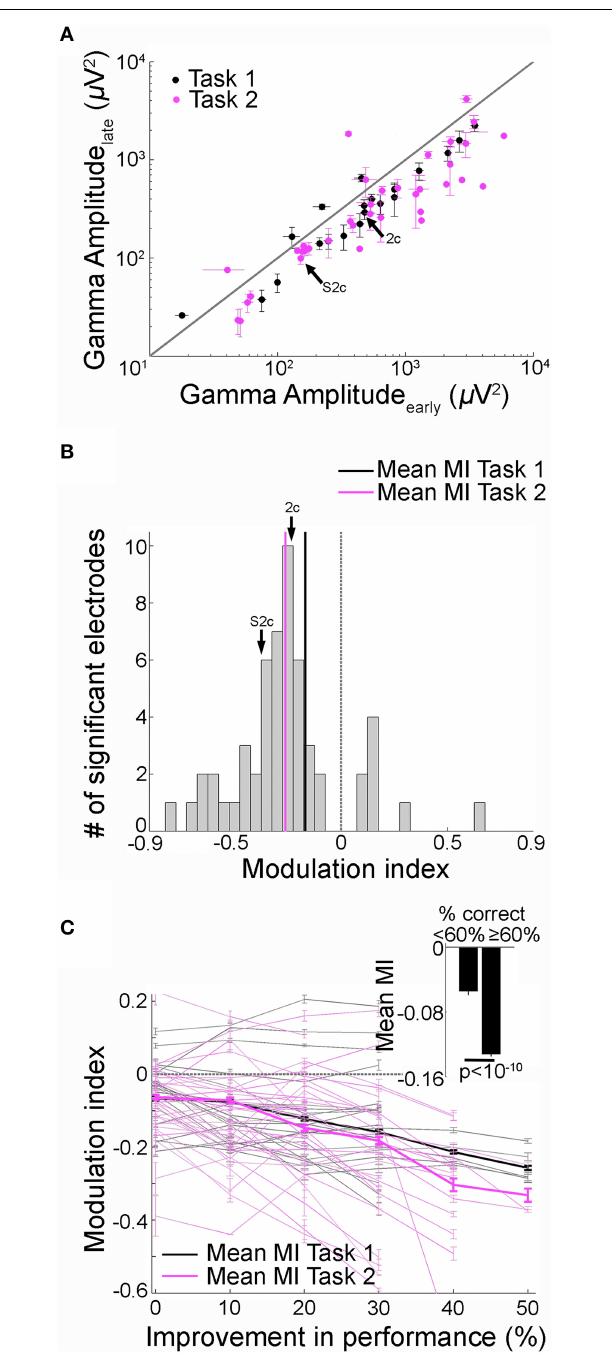
FIGURE 3 | Decrease in recall phase gamma frequency band amplitude over trials was directly correlated with learning. (A) Gamma frequency band amplitudes in the late (y-axis) vs. early (x-axis) trials during the recall phase (black = Task 1; Pink = Task 2). Data from 51 electrodes that showed significant changes in gamma-band amplitudes with learning from 11 subjects that reached the behavioral learning criterion ( Figure 1 , Materials and Methods). The arrow points to the example electrode shown in Figure 2 and Supplementary Figure 2. Error bars represent SEM. The diagonal represents no change between early and late trials. (B) Distribution of modulation index (MI) values between early and